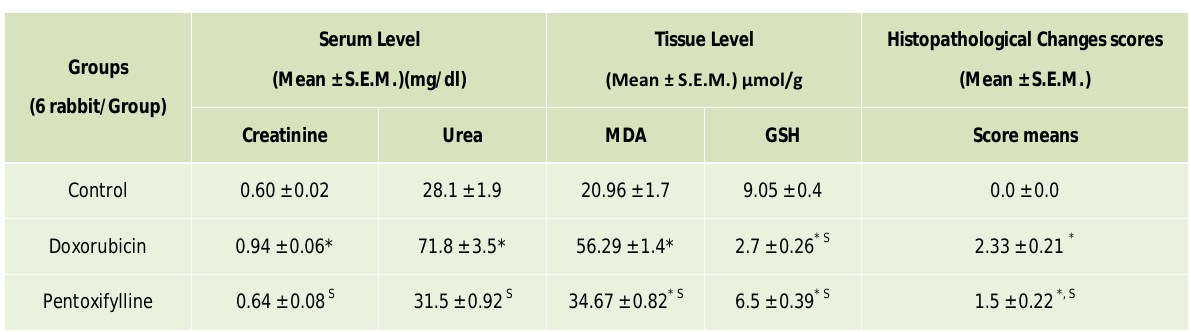
Table 1: Effect of pentoxifylline on means of serum creatinine, serum urea, tissue malondialdehyde, tissue glutathione and histopathological scores levels of rabbits with doxorubicin-induced nephrotoxicity.